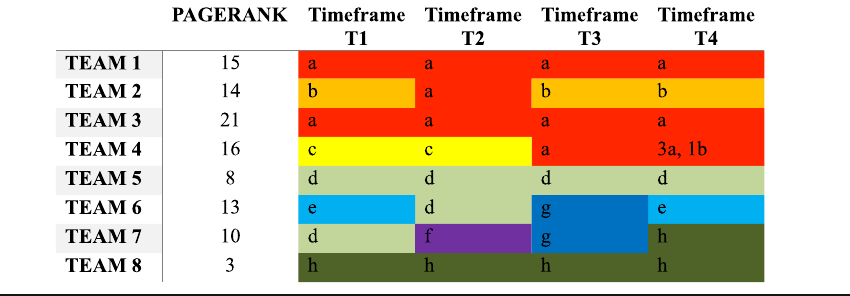
Lines represent the teams, while colored columns represent 4 consecutive timeframes. The PageRank column depicts the value obtained by each specific team in the teams graph; for readability reasons, the value of the PageRank has been multiplied by 100 and rounded. Cell color depicts affiliation of at least 3 members of a team to a specific community. The letters in each cell bring additional information about community membership: in case a cell has only one letter, then all the members of that respective team are part of the same community (e.g.: in timeframe T1, all members of Team 1 are part of community a ). Otherwise, a number in front of each letter represents the count of team members that are part of the community specified by that letter (e.g.: in timeframe T4 , 3 members of Team 4 belong to community a and 1 member to community b